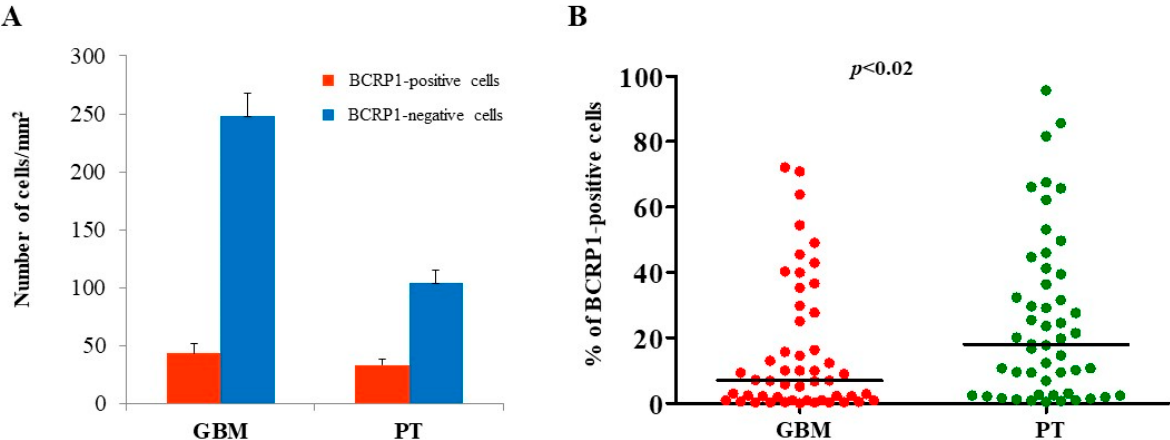
Figure 3. Stereological analysis of BCRP1 expression in both GBM and PT areas. Immunohistochemistry results were further evaluated by subjecting histological slides to an unbiased stereological analysis. Both BCRP1-labeled and unlabeled cells were counted, and the cell density of BCRP1 was graphed. ( A ) Red and blue bars show the number of BCRP1 cells/mm 2 . The data are presented as the mean ± SE. ( B ) Plots show the percentage of positive cells in GBM and PT areas. N = 50; the horizontal line represents the median value; p indicates the result of the Mann-Whitney